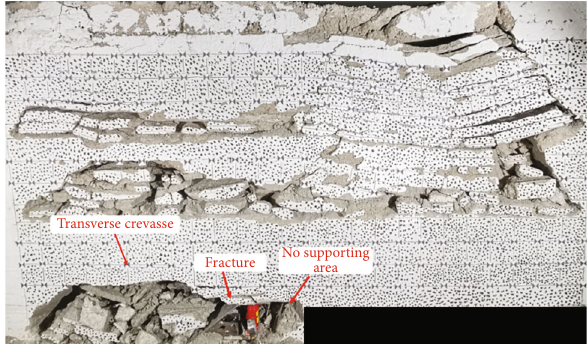
Figure 10: Exposed state of end face roof in moving process.